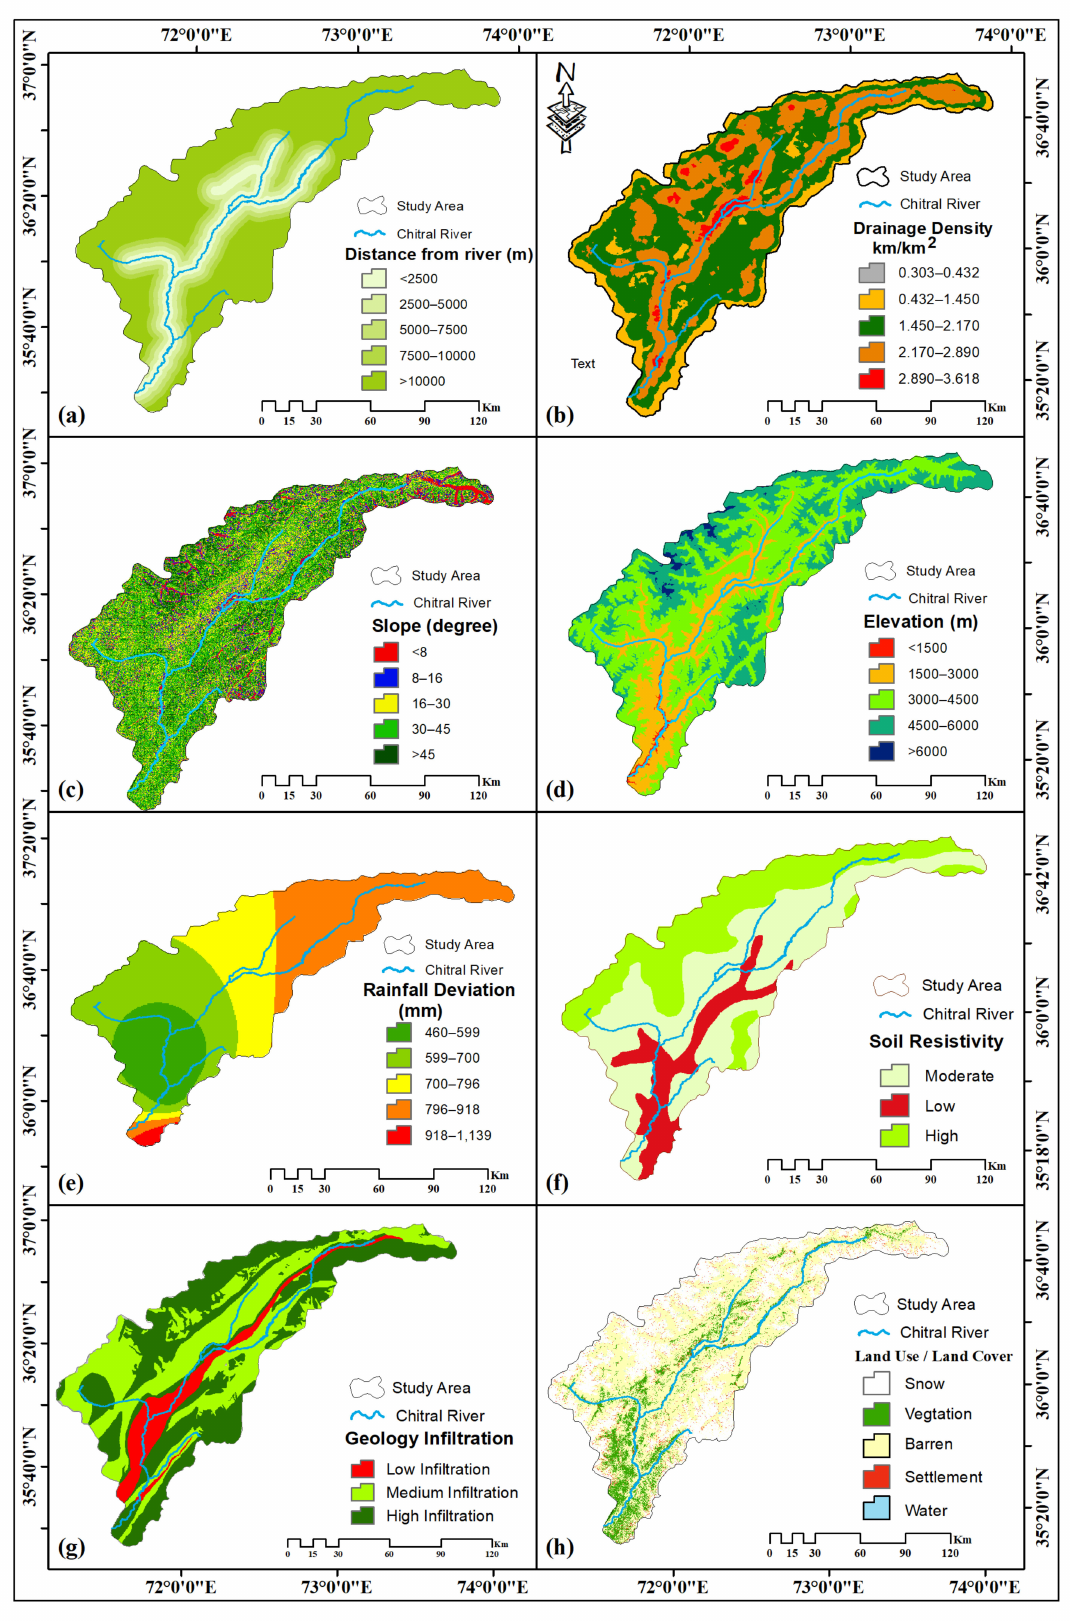
Figure 3. In this study, maps of flash flood conditioning variables were used: ( a ) distance from the river, ( b ) drainage density, ( c ) slope, ( d ) elevation, ( e ) rainfall deviation, ( f ) soil resistivity, ( g ) geology infiltration, and ( h ) land